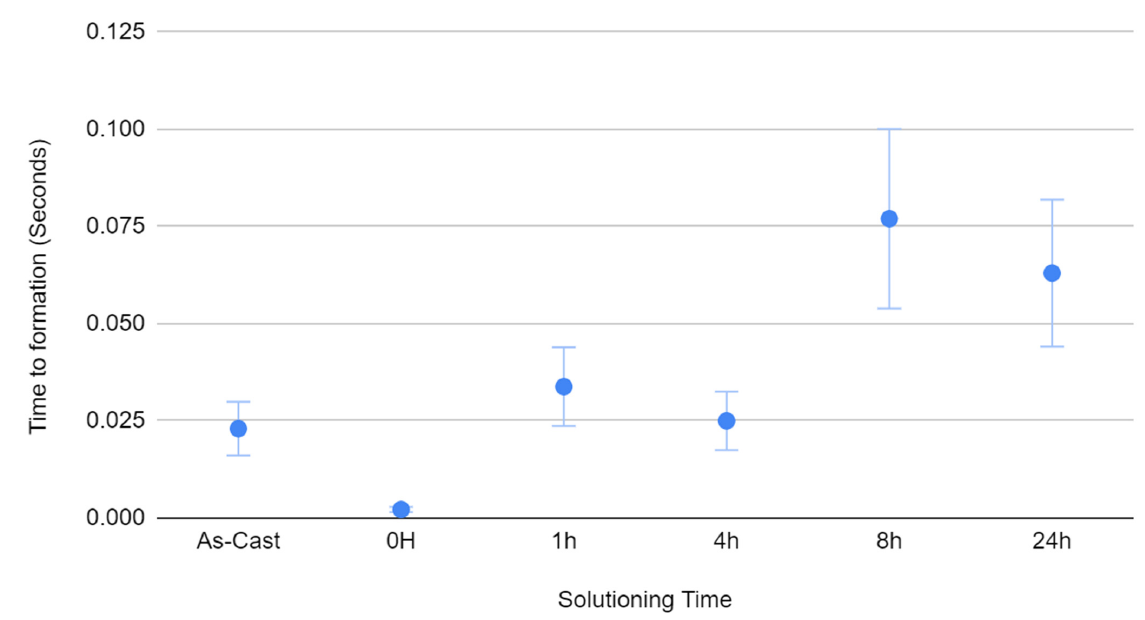
Figure 4. The time-to-formation of σ -phase for dendritic core compositions taken from various so- lution process times for